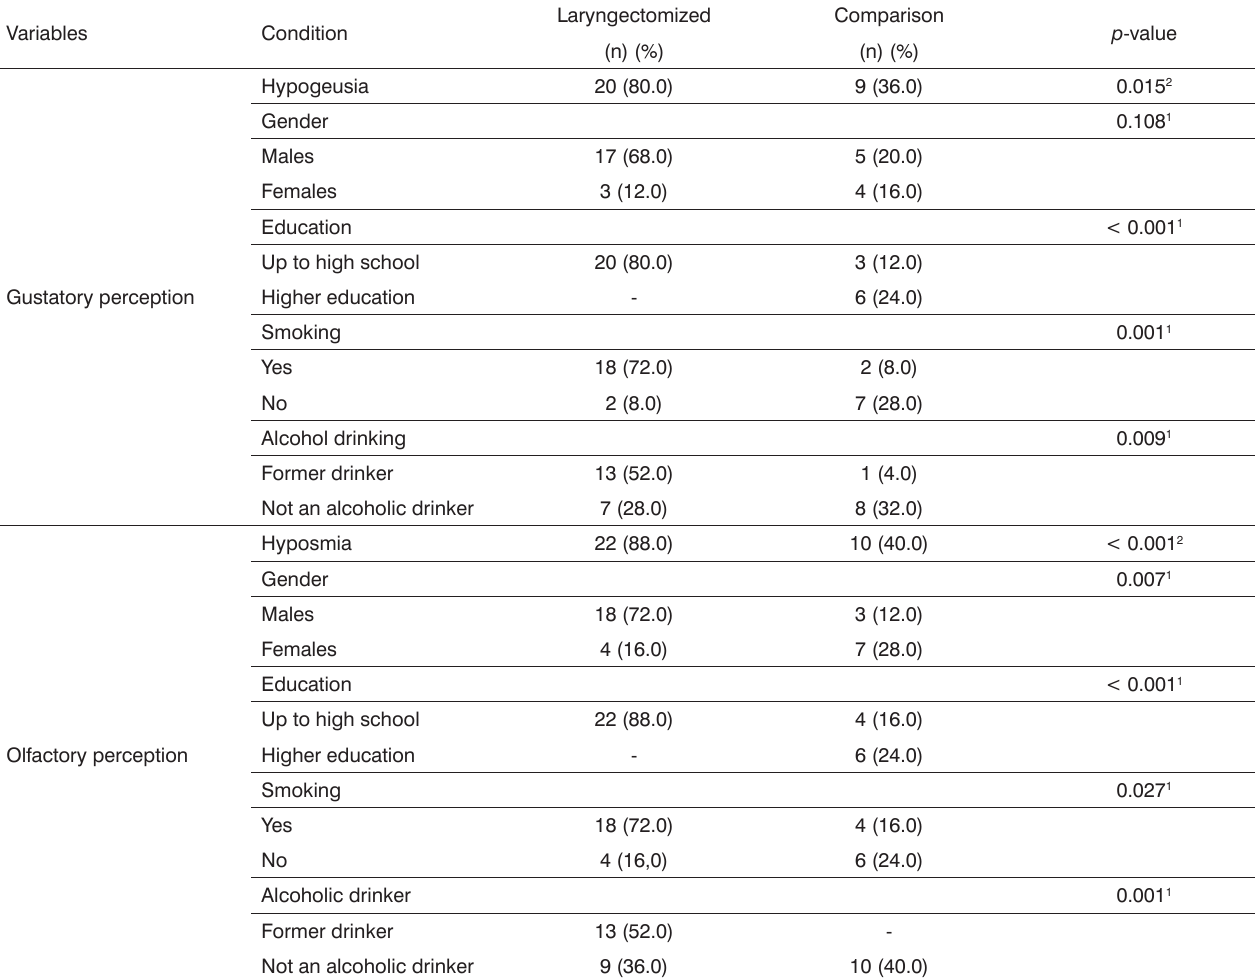
Table 2. Distribution of comparisons between the laryngectomized patients’ group and the comparison group according to gustatory and olfactory discrimination by gender, educational level, smoking and alcohol